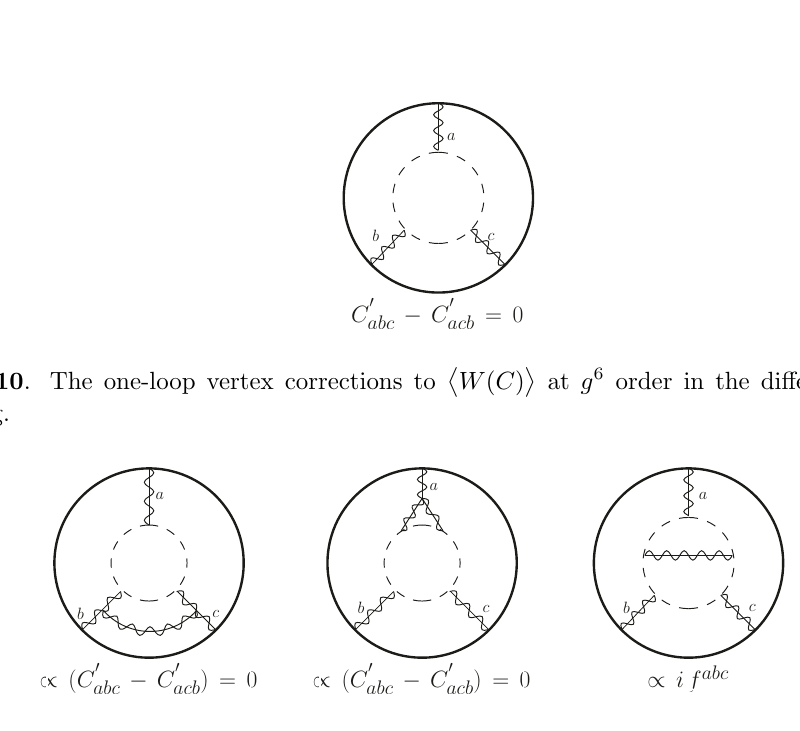
Figure 11 . Possible two-loop vertex corrections contributing to their color